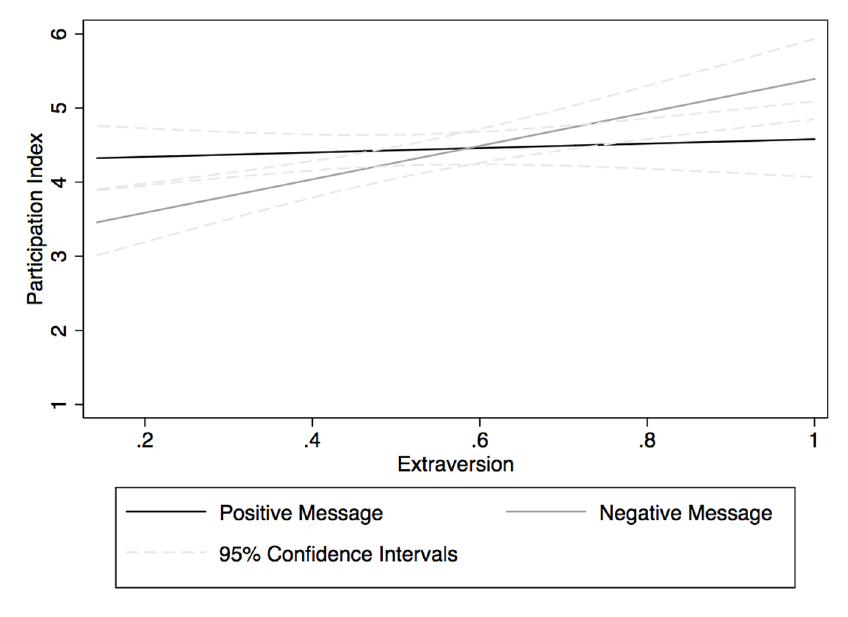
Figure 2. Interaction between extraversion and negative political message. Note. Other variables in model set at median